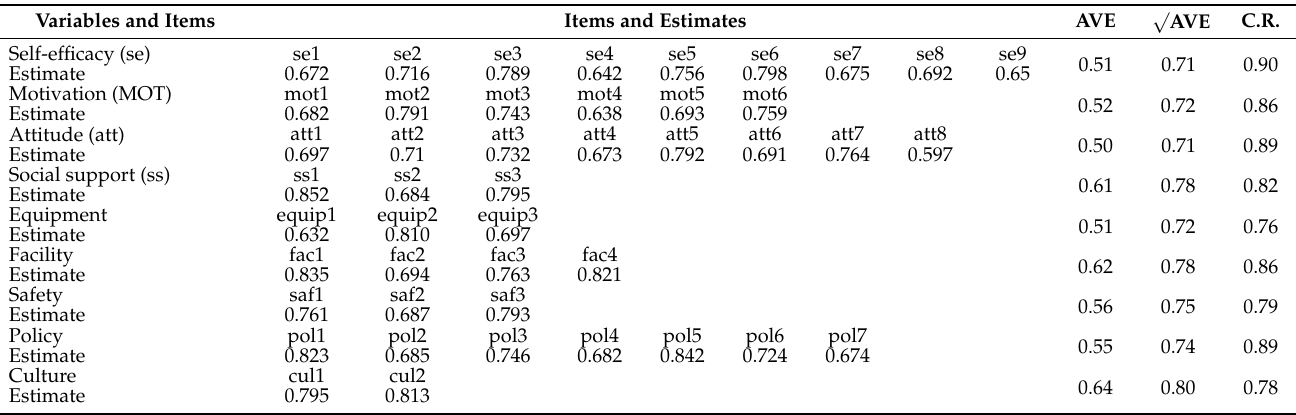
Table 1. Validation of